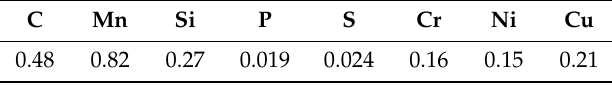
Table 5. Chemical composition in wt % of the S48C steel grade.